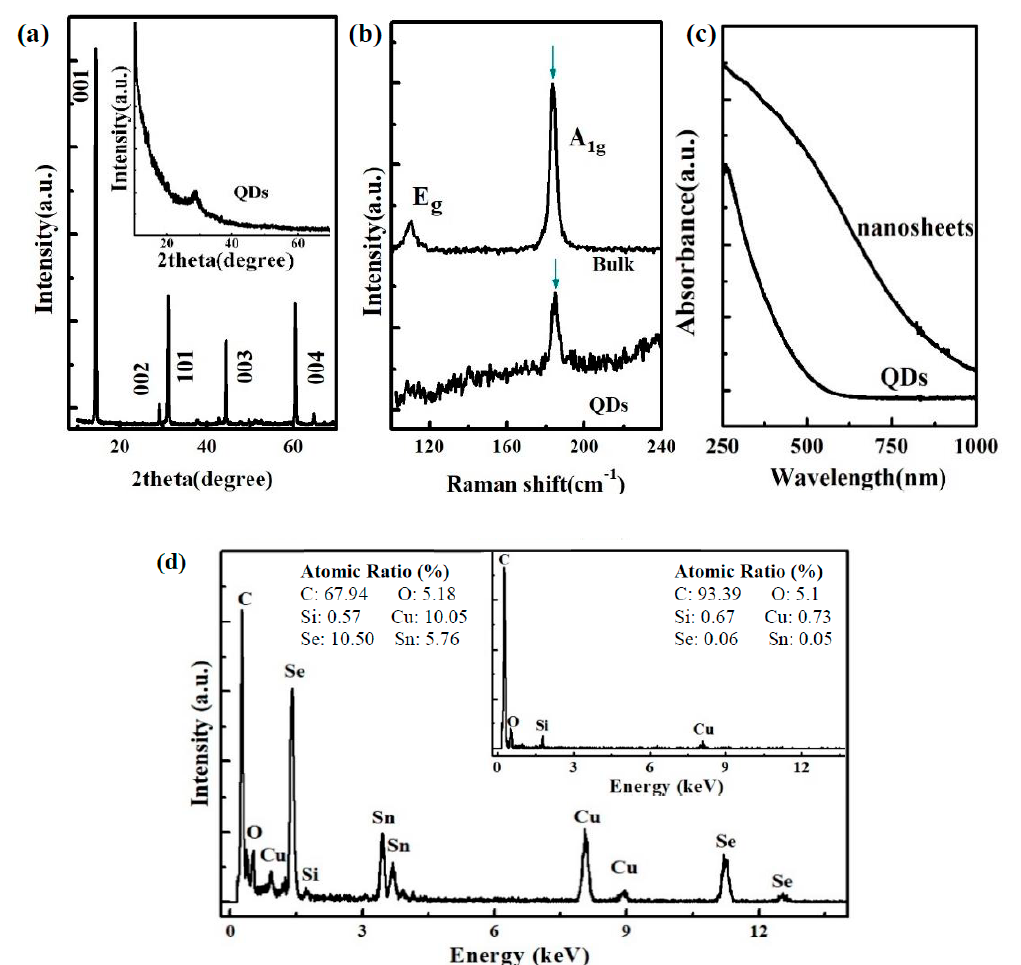
Figure 3. Spectroscopic characterizations. ( a ) XRD pattern of the SnSe 2 bulk and QDs; ( b ) Raman spectra of the SnSe 2 bulk and QDs; ( c ) absorption spectra of the SnSe 2 QDs and nanosheet solutions; ( d ) TEM energy dispersive spectra (TEM-EDS) of the SnSe 2 QDs. The inset shows the EDS of the TEM substrate without QDs.